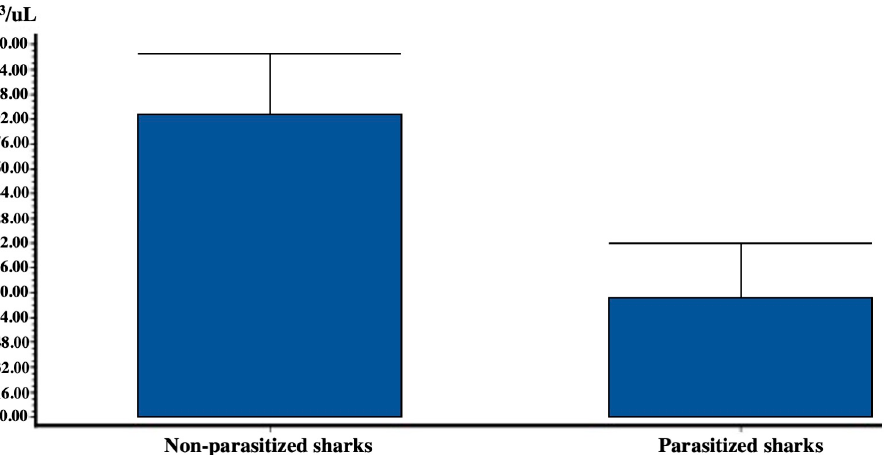
Figure 5. Difference ± sd between leukocyte count (10 3 / µ L) and presence/absence of parasites (N of non-parasitized sharks = 25; N of parasitized sharks = 7).